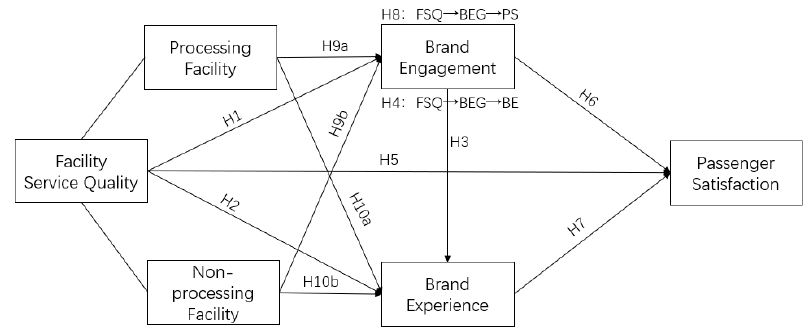
Figure 1. Hypothesized